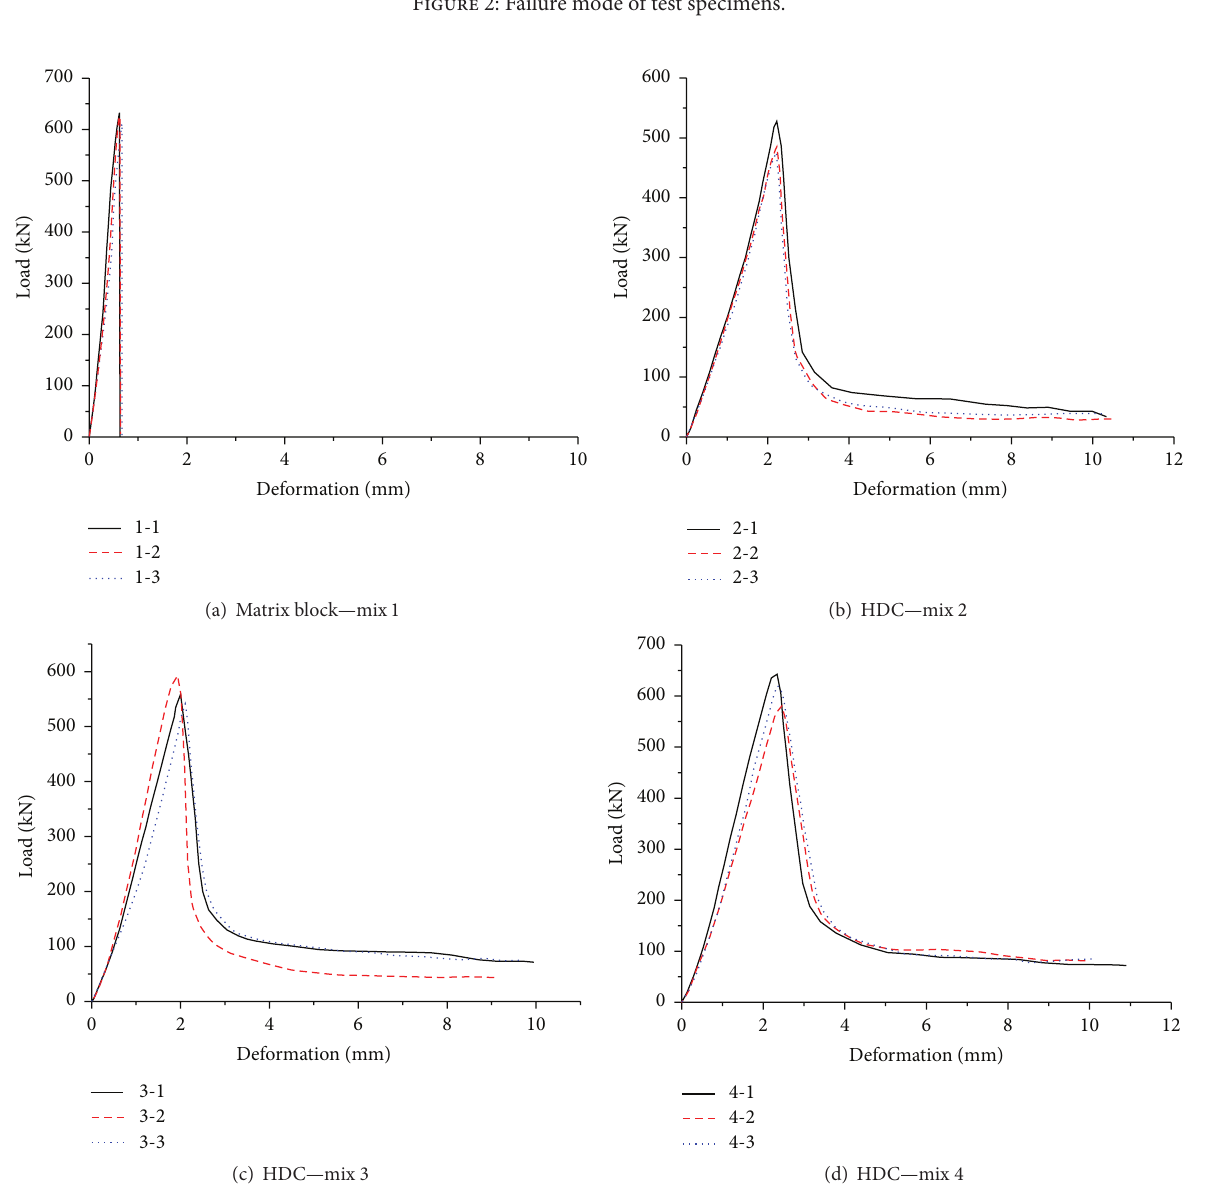
Figure 2: Failure mode of test specimens.